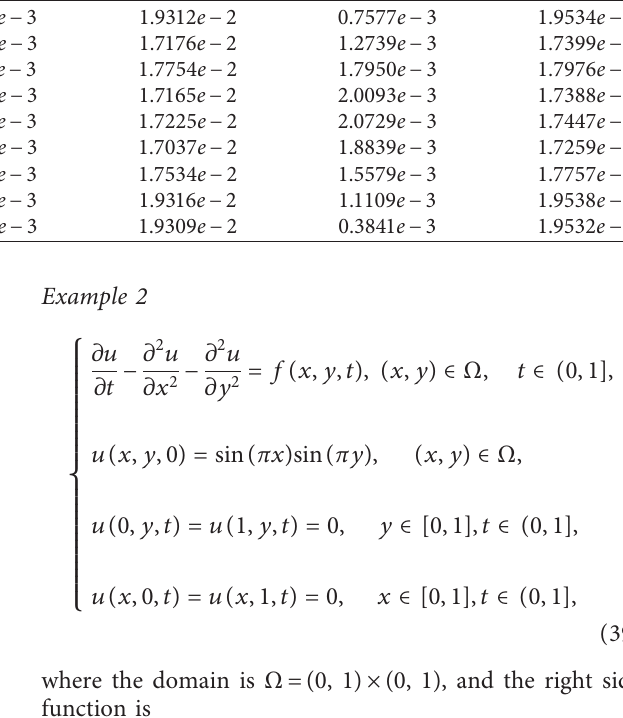
Table 2: The absolute errors and relative errors of numerical solutions to Example 1 for h � 1/19 (i.e., K � 3). Algorithm 1 ( t � 0.2) Algorithm 1 ( t � x j